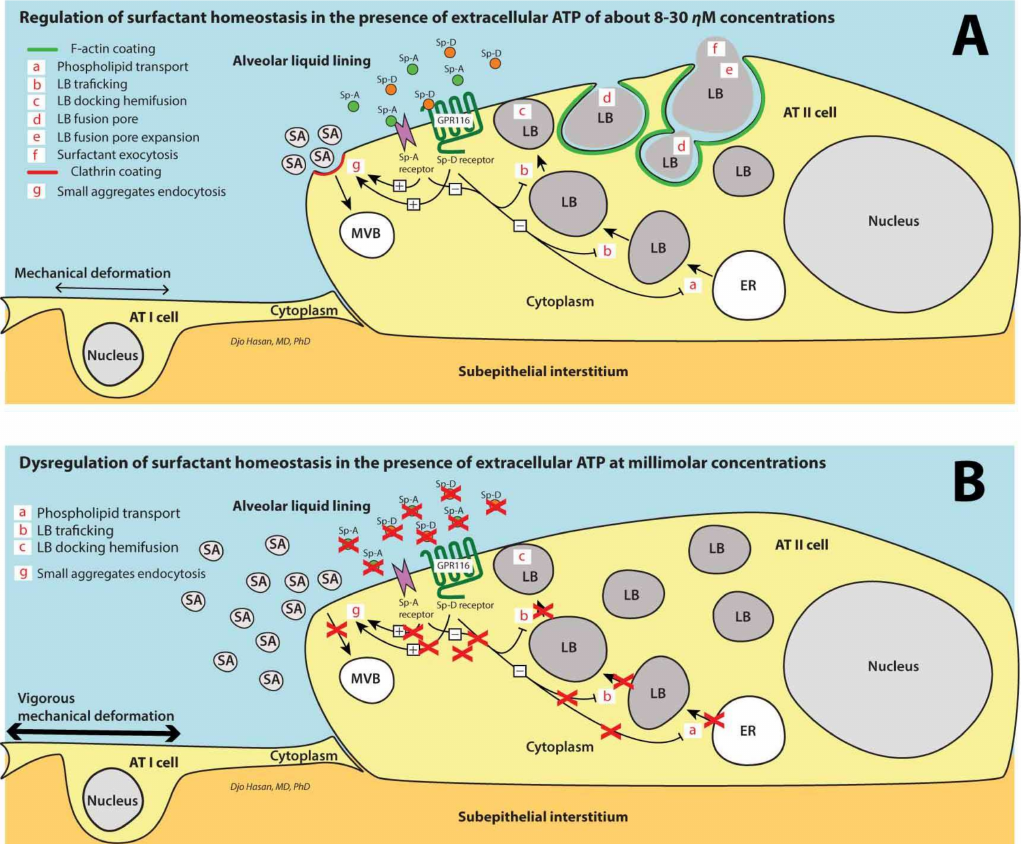
Figure 2. Schematic presentation of the surfactant homeostasis of the alveolar epithelial cells. ( A ) A perivesicular F-actin coating is formed around the fused LBs after the initial LB fusion pore has developed. Several types of fusion pore development are described [57]: (1) 80% of the F-actin-coated fused LBs release surfactant and the LB membrane becomes part of the plasma membrane (kiss-coat-and-release) followed by the disappearance of the F-actin coat; (2) 10% of the F-actin-coated fused LBs discontinued the fusion process and returned inside the cell (kiss-coat-and-run); (3) In the remaining F-actin-coated LBs the fusion process was arrested for a certain time (<20 min) (kiss-coat-and-wait) [57]. The endocytosis of SAs occurs through a clathrin-dependent pathway [59] by the activation of several types of SP-A receptors [59–63] and a SP-D receptor [64]. The SP-D receptor is a GPR116, also known as Ig-Hepta that are highly expressed in the lung [64]. Besides SAs uptake, this process also inhibits the surfactant exocytosis and contributes to the control of extracellular surfactant homeostasis [59,64]. ( B ) The activation of the pro-inflammatory response of the innate immune system through the activation of the P2X7Rs by extracellular ATP at >300 µ M concentrations (ATP molecules at these concentrations act as DAMPs) leads to the recruitment and activation of neutrophils. The recruited and activated neutrophils cause the degradation of SP-D and SP-A leading to a deficiency of SP-D and SP-A [65,66] preventing the clathrin-dependent recycling of the majority of SAs and aborting the above-mentioned inhibition of the trafficking, semi-fusion and fusion of the LBs with the cell membrane. AT I: Alveolar epithelial type I cell; AT II: Alveolar epithelial type II cell; ER: Endoplasmic reticulum; LB: Lamellar body; MVB: multivesicular body; SP-A: Surfactant protein A; SP-D: Surfactant protein D; SAs: Surfactant small aggregates; LAs: Surfactant large aggregates; GPR116: G protein-coupled receptor 116; DAMPs: danger-associated molecular